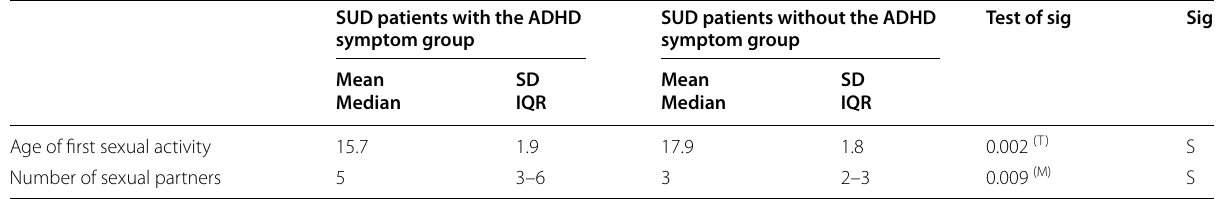
Table 4 Comparison between SUD patients with the ADHD symptom group and SUD patients without the ADHD symptom group regarding sexual risk